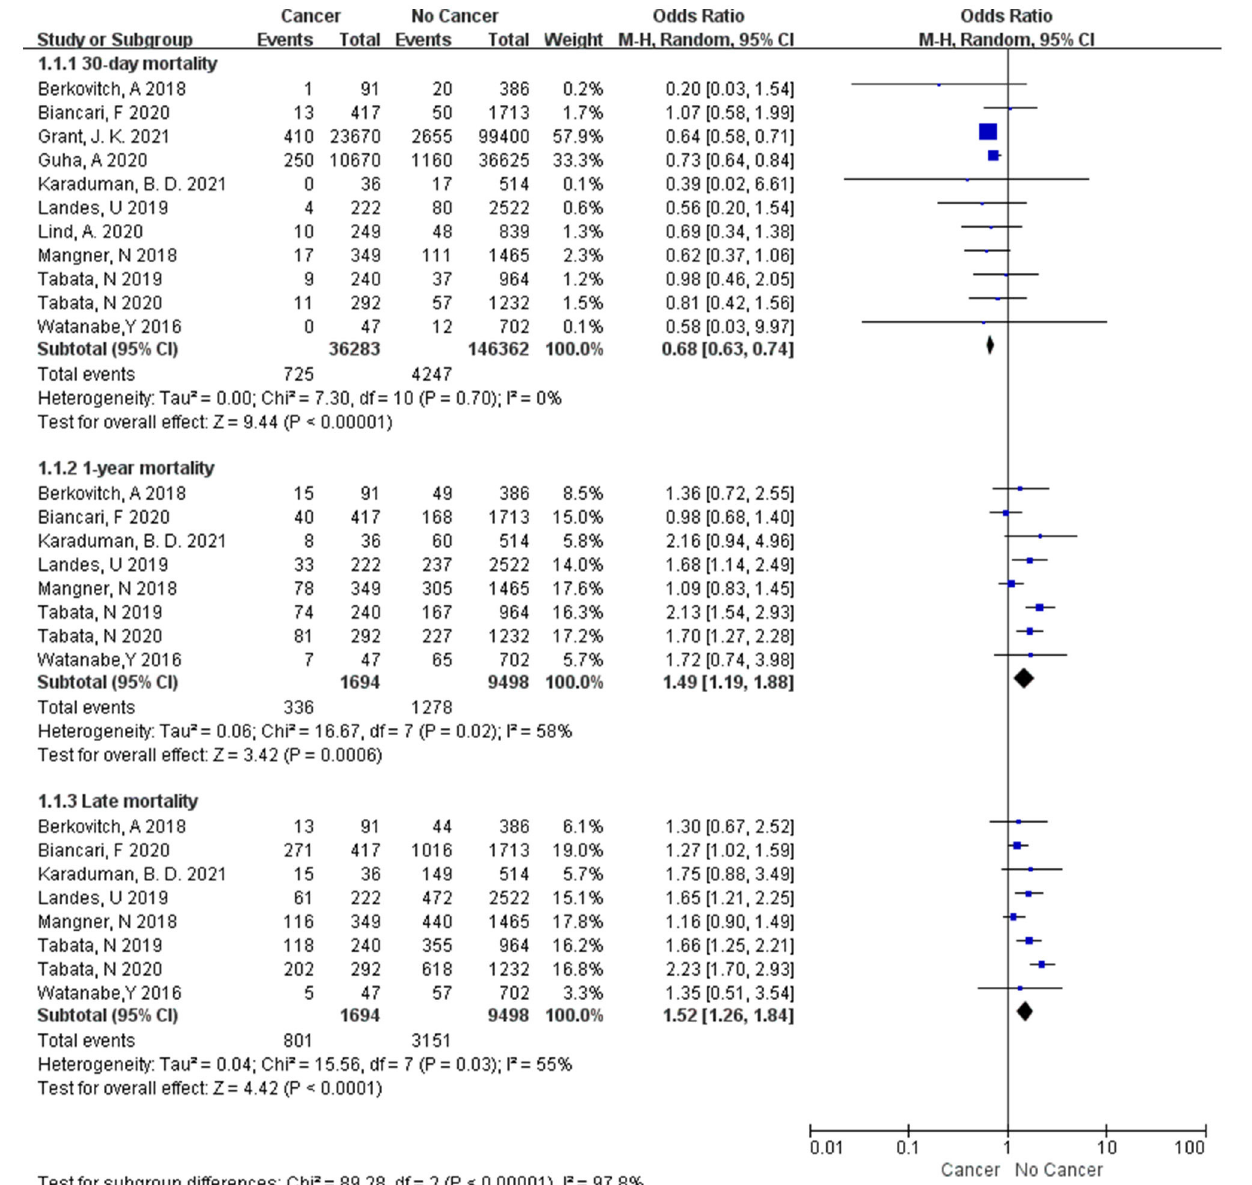
FIGURE 2 | The forest plot of all-cause